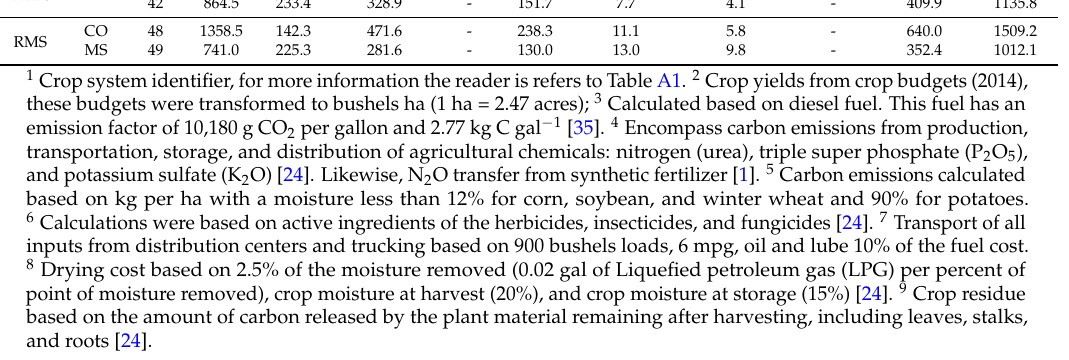
Table A5. Carbon equivalent emissions for corn systems in the United States.